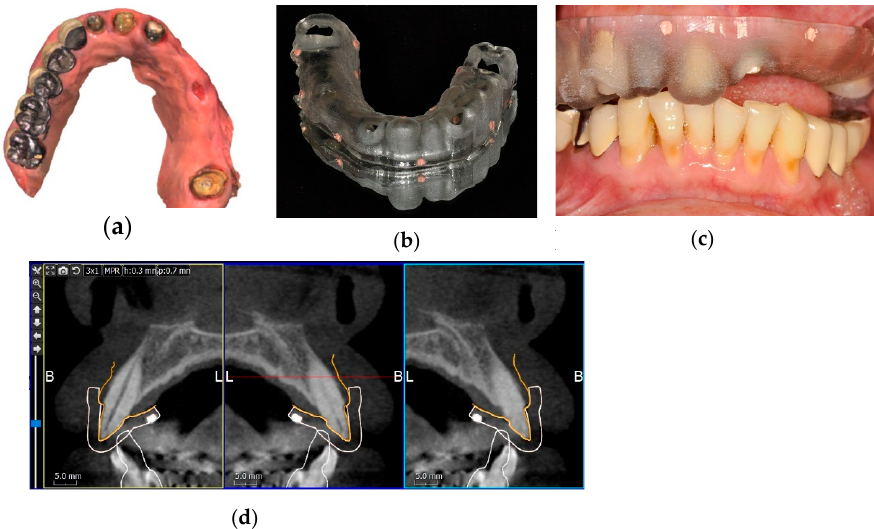
Figure 2. Fiducial marker protocol of implant planning. ( a ) An occlusal image of a maxillary intraoral scan. Five metal crowns on the right side and the inadequate number of residual teeth made the correct alignment of CBCT and intraoral scans by dental surface registration difficult. ( b ) Using the digital data of the intraoral scan, a stereolithographic (SLA) radiographic template with gutta-percha fiducial markers was fabricated. ( c ) The SLA radiographic template in the mouth ready for a CBCT scan. ( d ) A CBCT image aligned with the intraoral scan image (orange line) by matching the fiducial markers (white cubes) on the SLA radiographic template (white line).